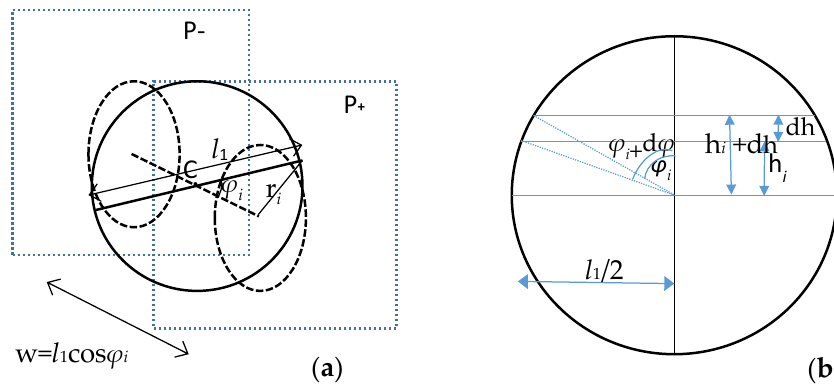
Figure 7. Figure for the quantification of factor α ϕ i : ( a ) Maximum crack width (w) of the strip that includes the center point of all fibers with orientation angle ϕ to the plane of the crack (P) that cross it; ( b ) Ratio of the surface areas of a spherical segment.